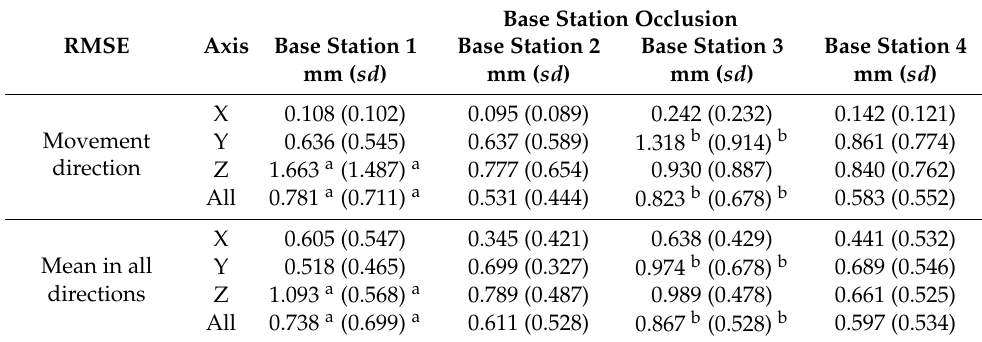
Table 5. Errors (mm) in tracking of translation with standard deviations ( sd ) of experiments with occluded SteamVR Base Stations 2.0; the numbering corresponds to that of Figure